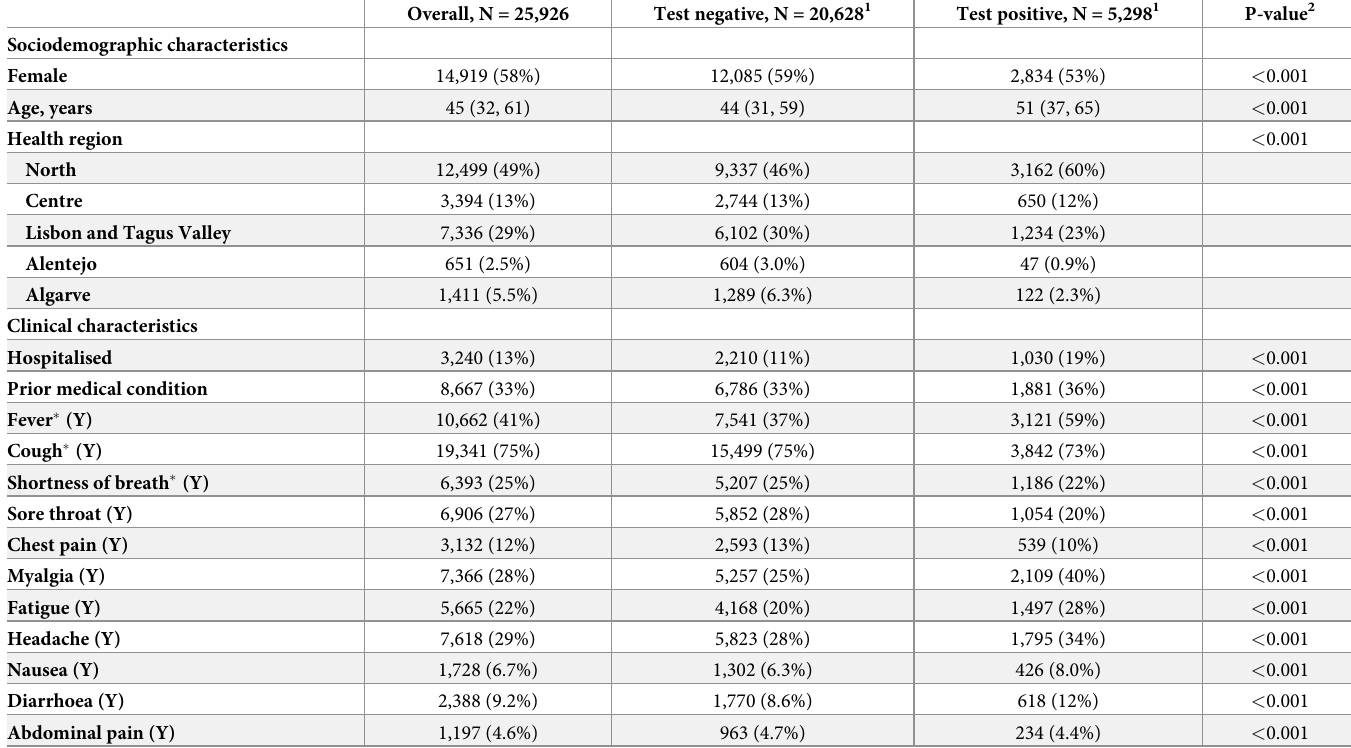
Table 1. Sociodemographic and clinical characteristics of study’s population by SARS-CoV-2 test result (N = 25,926).